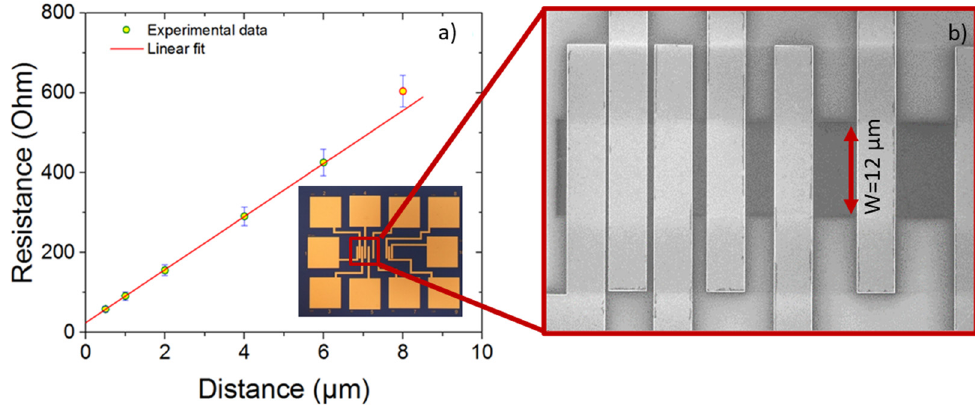
Figure 7. ( a ) Plot of resistance with TLM structure for a graphene width of 12 µm, inset is an optical image of a TLM structure ( b ) SEM image showing a magnification of the framed area in the inset.